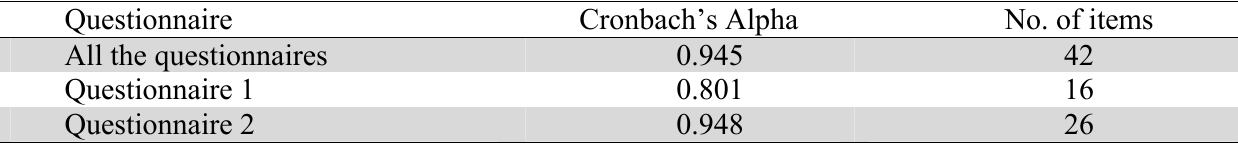
Cronbach’s Alpha for the questionnaires, using SPSS